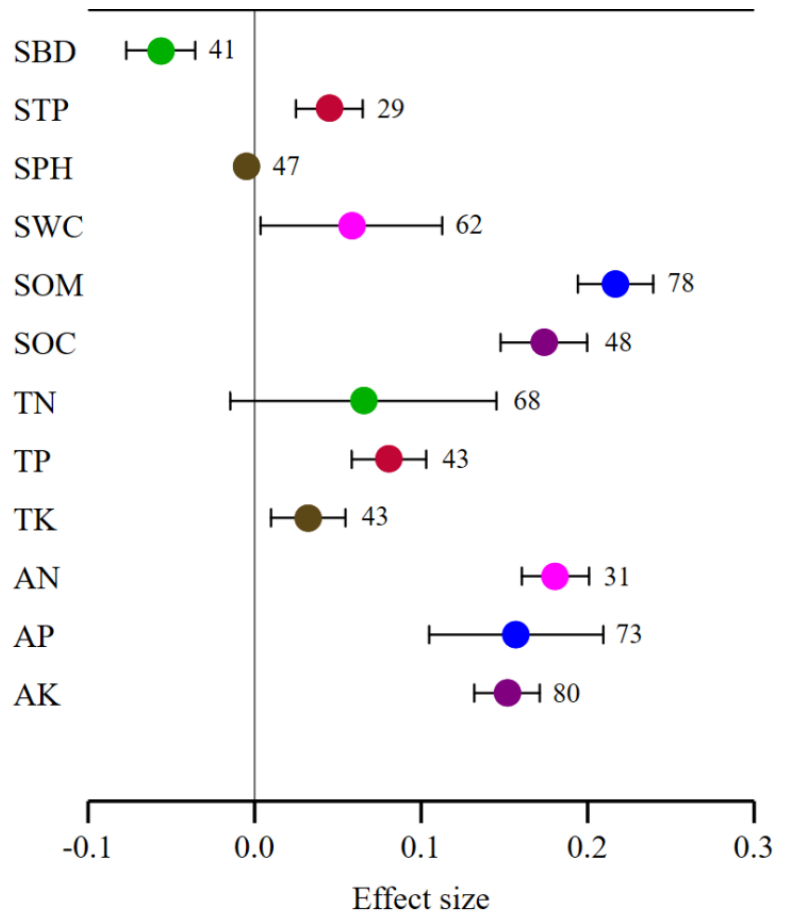
Figure 1. The overall effects of living grass mulch on soil physicochemical properties of apple orchards in China. Weighted means and their 95% confidence intervals of the effect sizes are given. The numbers on the right side of the confidence intervals represent the sample sizes. SBD: soil bulk density; STP: soil total porosity; SPH: soil pH; SWC: soil water content; SOM: soil organic